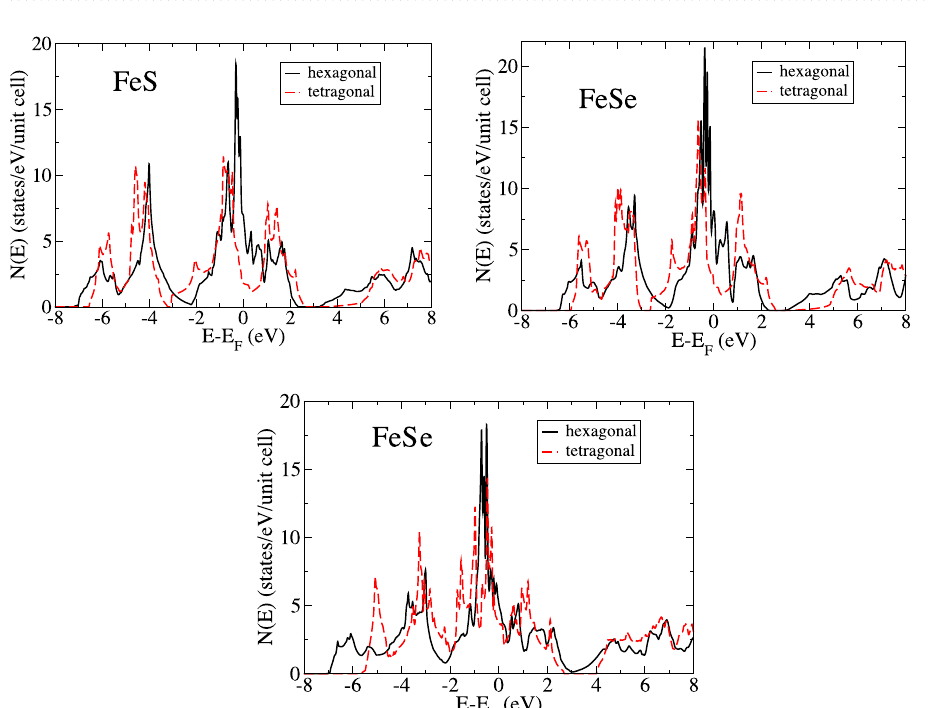
Figure 2. The calculated densities-of-states for FeS (top left), FeSe (top right) and FeTe (bottom), for the hexagonal (black solid line) and tetragonal (red dashed line)